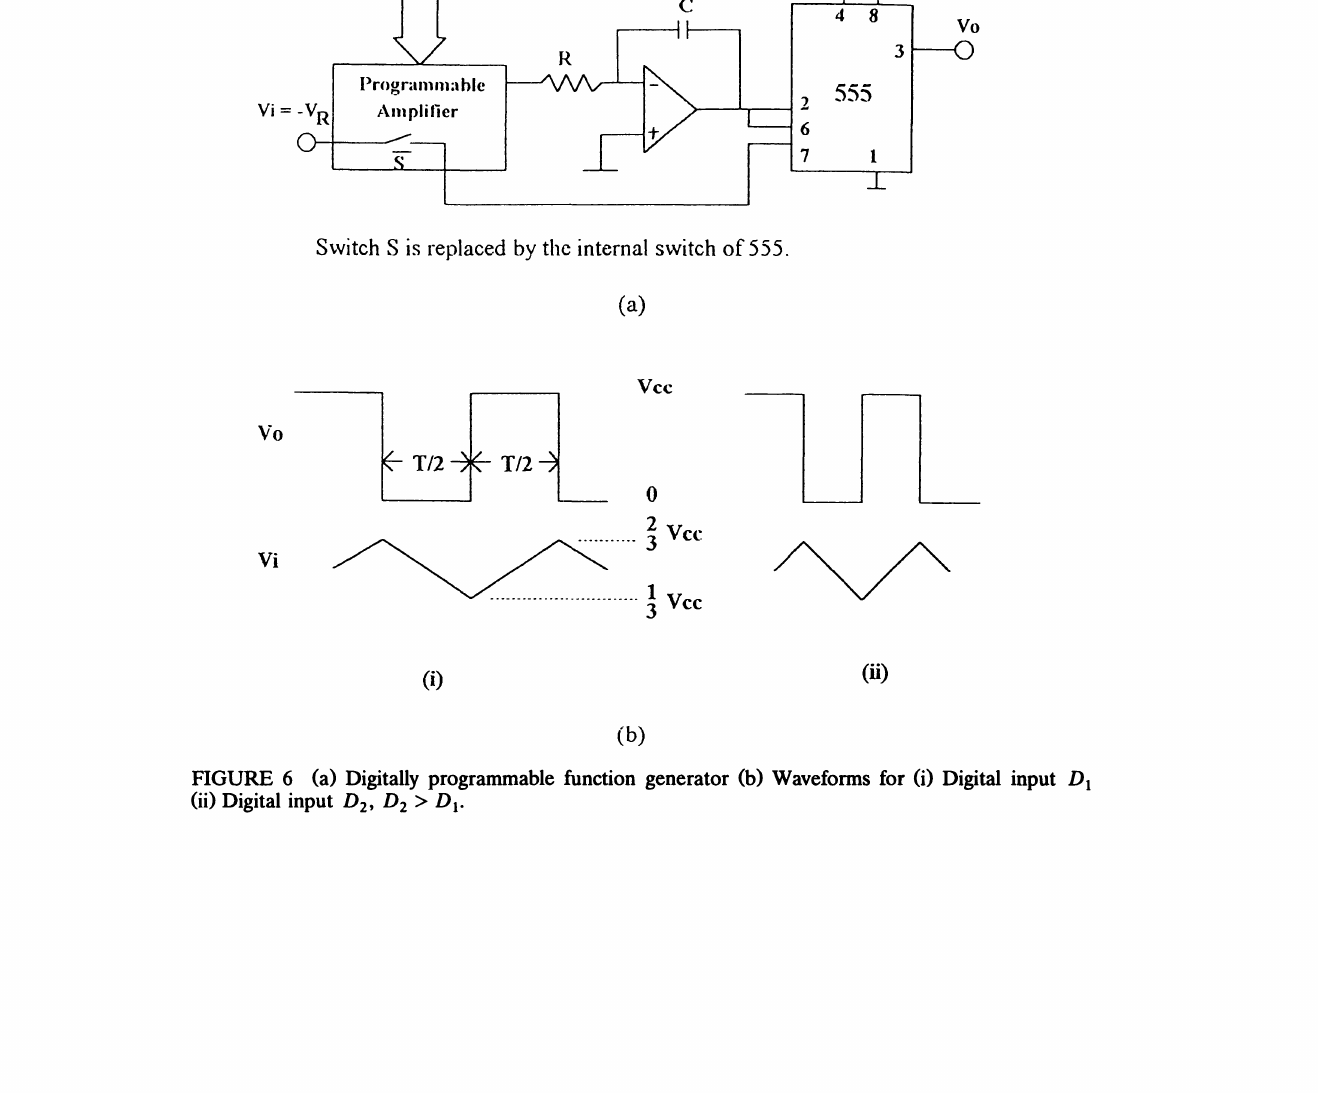
FIGURE 5 Compensated amplifier with reduced total resistance Digital Input.